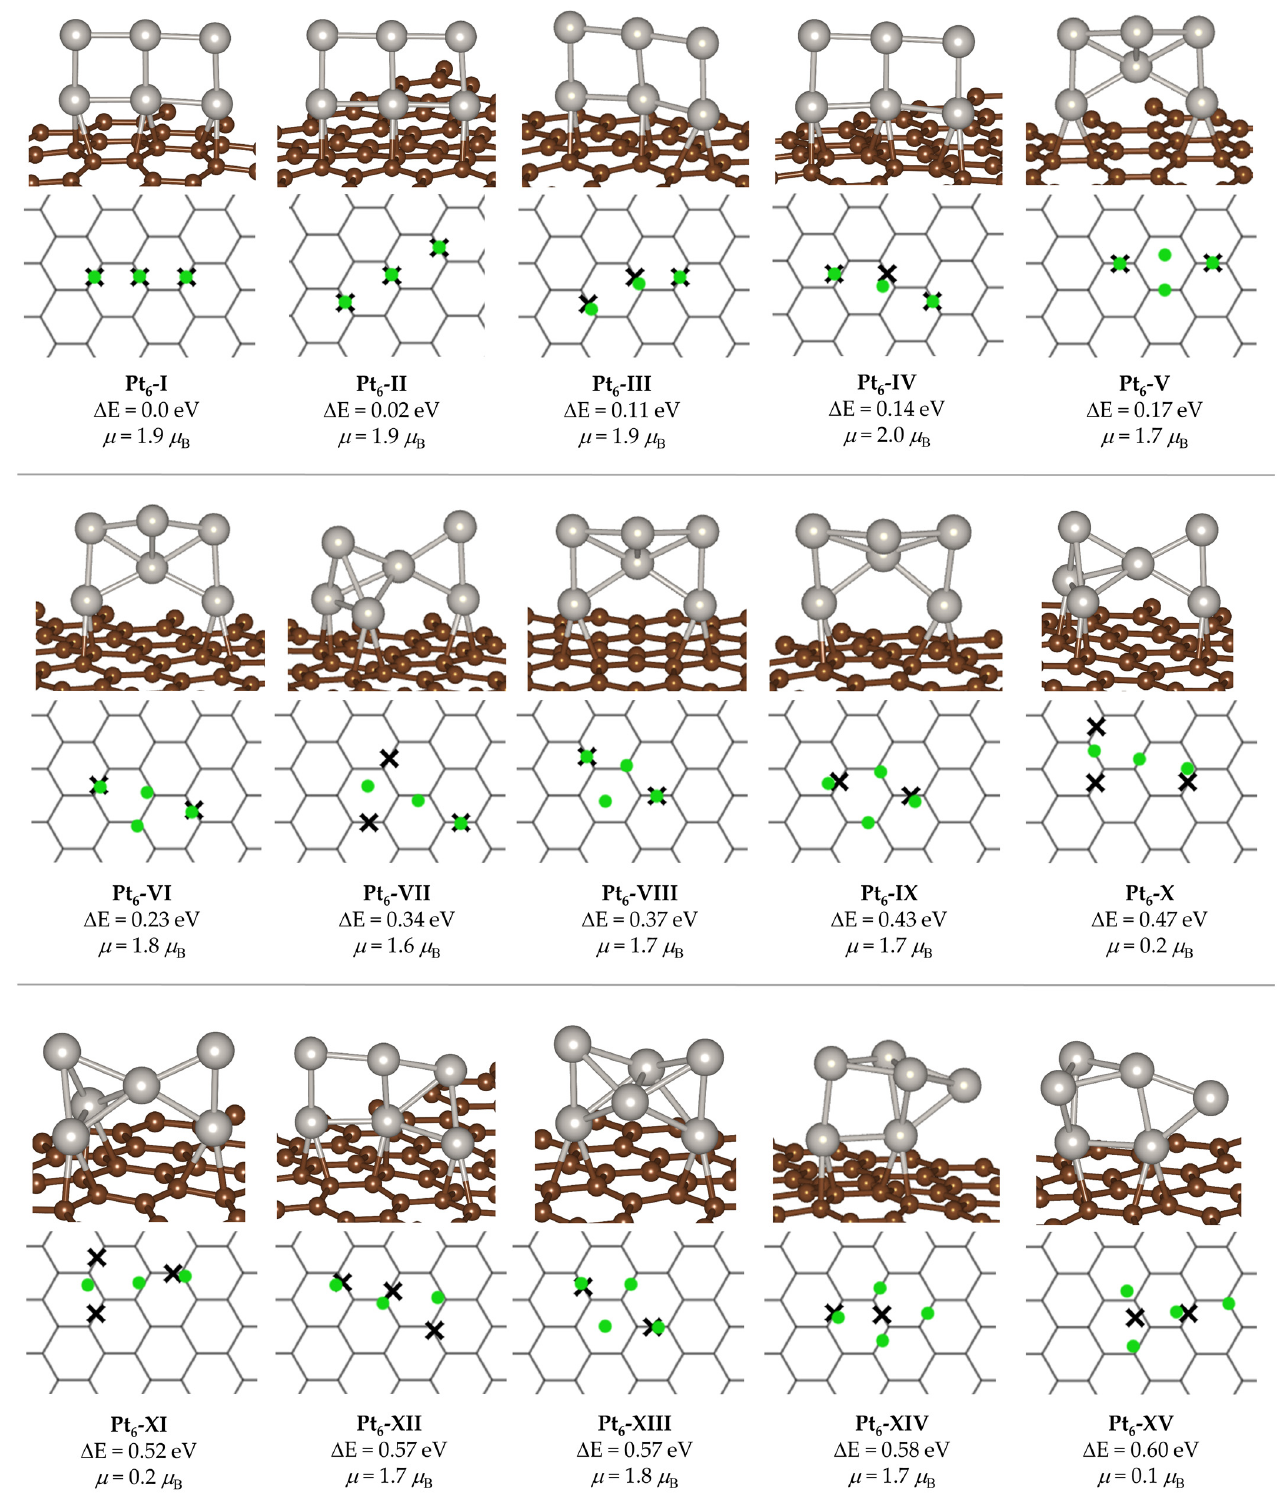
Figure 1. Frontal and schematic top views for the fifteen lowest-in-energy local minimum for Pt 6 /graphene optimized with dispersion-corrected DFT. ∆ E corresponds to the energy difference with respect to the GM; the total magnetic moment of the system (per unit cell) is provided in Bohr magnetons. The green dots correspond to the Pt atoms at the top, while the black crosses correspond to the atoms at the bottom.